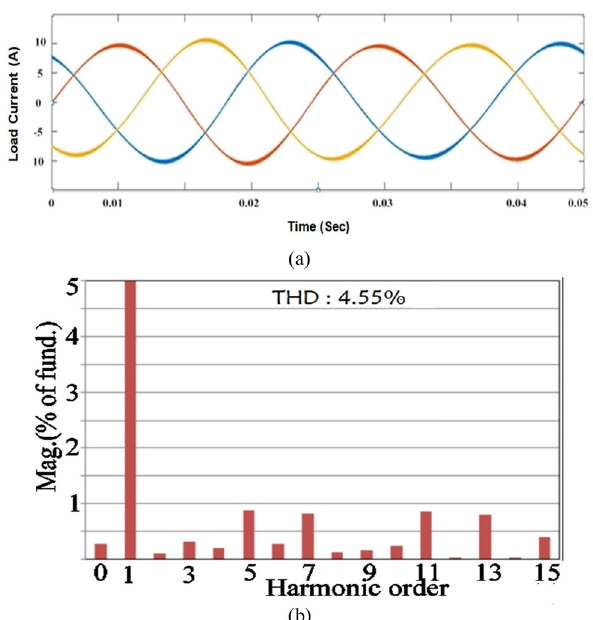
Figure 9: Results for natural reference frame: ( a ) inverter output current and ( b ) THD of output current.